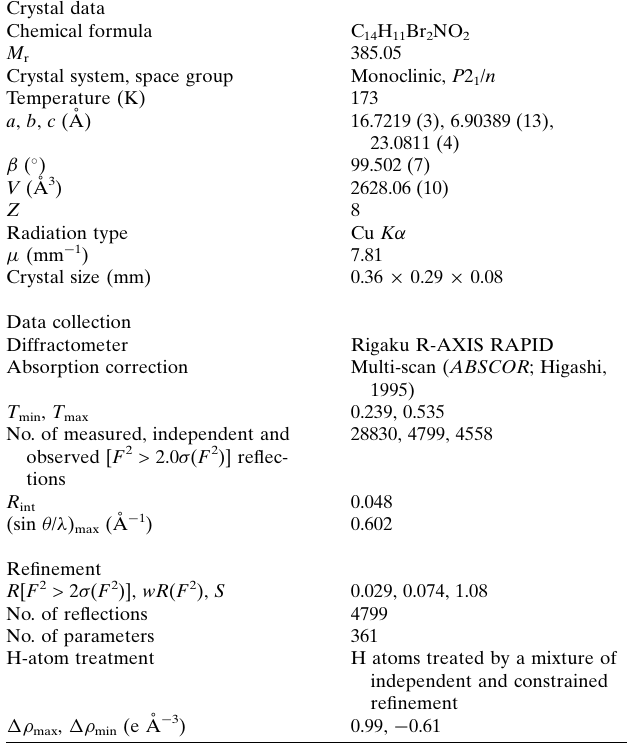
Table 2 Experimental details. Crystal data Chemical formula